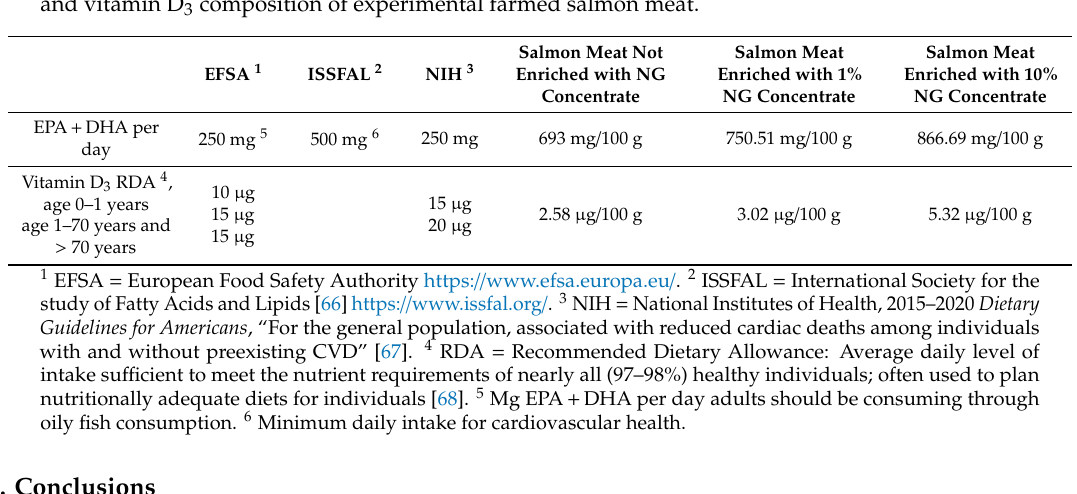
Table 9. Recommended daily intake of n-3 Fatty acid and vitamin D 3 compared with n-3 Fatty acid and vitamin D 3 composition of experimental farmed salmon